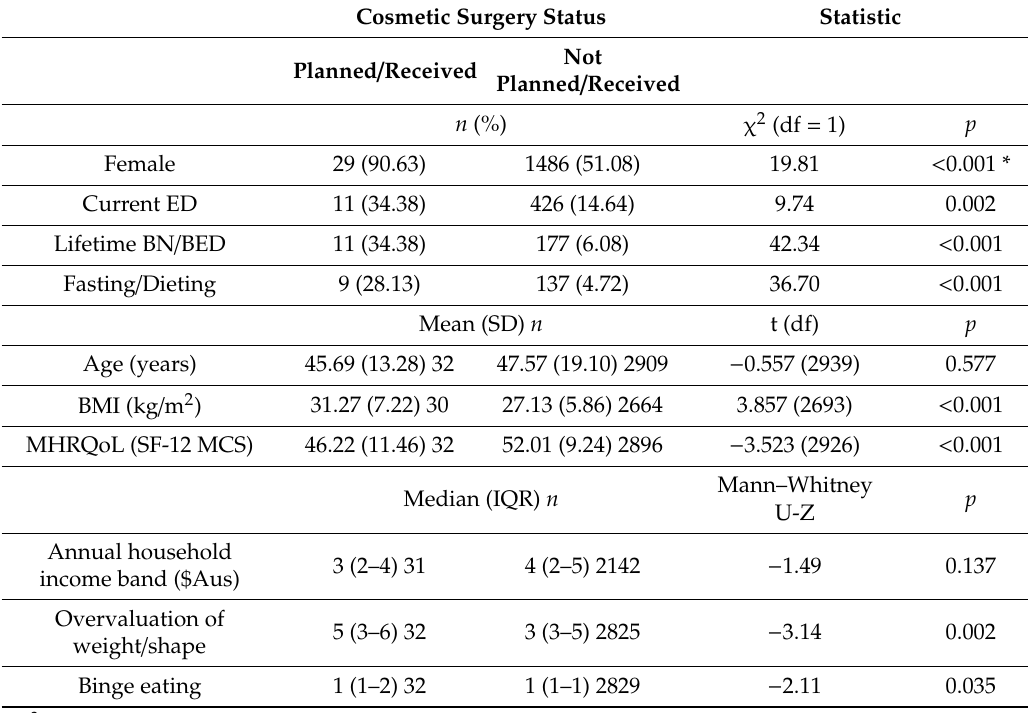
Table 2. Demographic, mental health and ED features of people who had planned or received cosmetic surgery ( n = 32) and not planning or having received cosmetic surgery ( n =